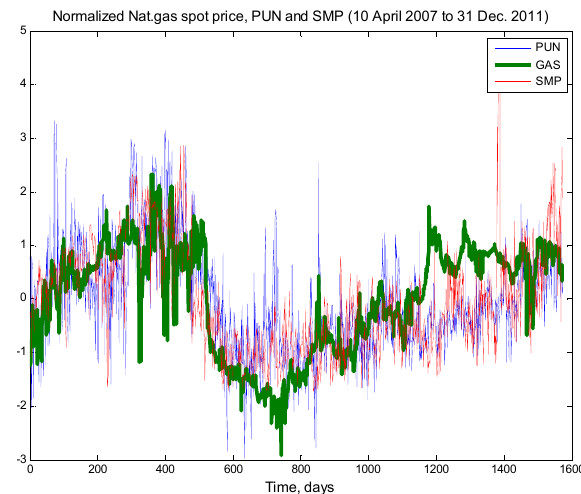
Figure 8. Co-evolution of PUN, Natural gas spot price (UK Hub) and SMP, as a first visual inspection of co-movement of Italian and Greek markets due to a common fundamental dynamic driver (natural